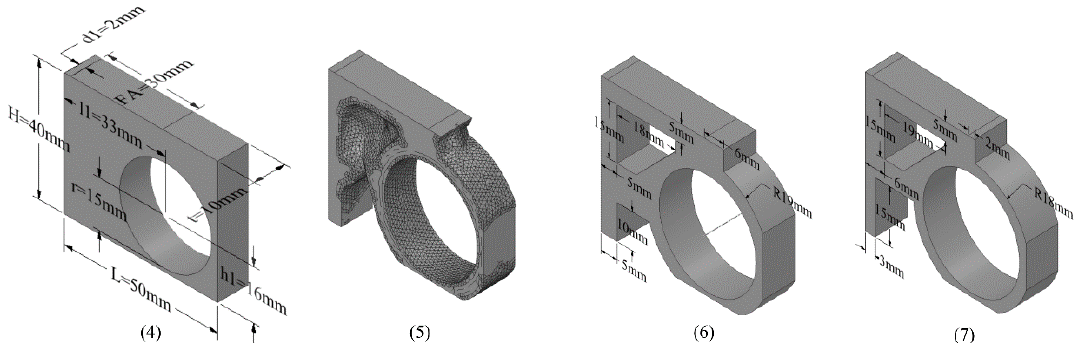
Figure 12. The four design processes in the PO workflow: (4) parametric size / shape optimization (PO), (5) parametric size / shape, and topology optimization with no redesign (PO_TO_NR), (6) parametric size / shape, and topology optimization with redesign (PO_TO_R), and (7) parametric size / shape, topology optimization with redesign, and parametric shape optimization (PO_TO_R_PO).